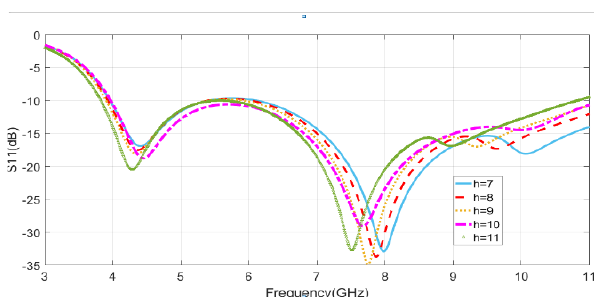
Figure2: Simulated S 11 characteristics of the proposed UWB cylindrical DRA monopole antenna without slots for